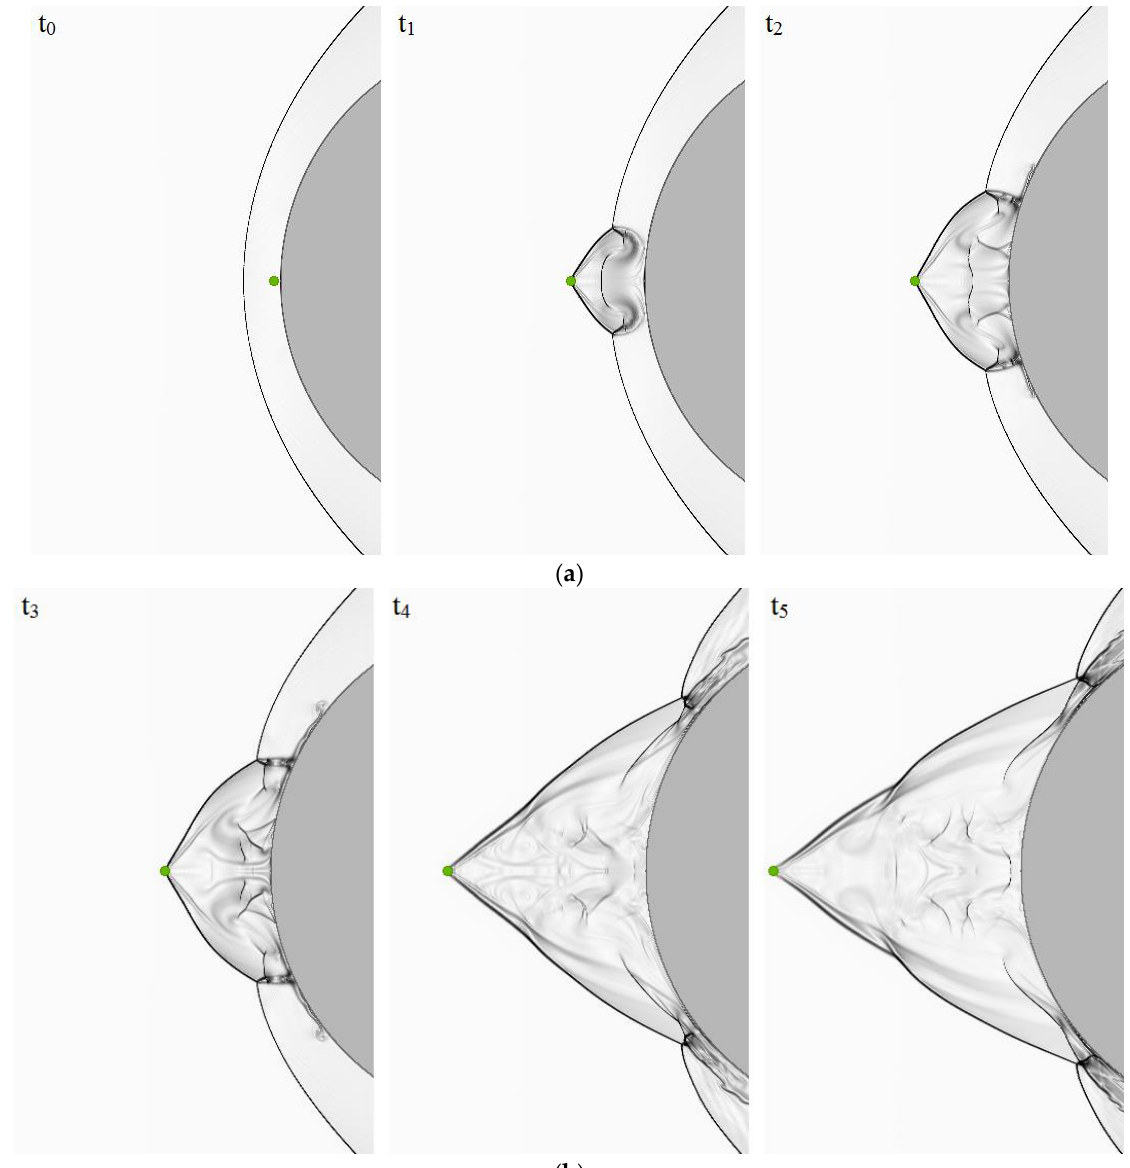
Figure 7. ( a ). Shadow pictures of the flow in the process of particle movement along the symmetry axis. ( b ). Shadow pictures of the flow in the process of particle movement along the symmetry axis (continued).